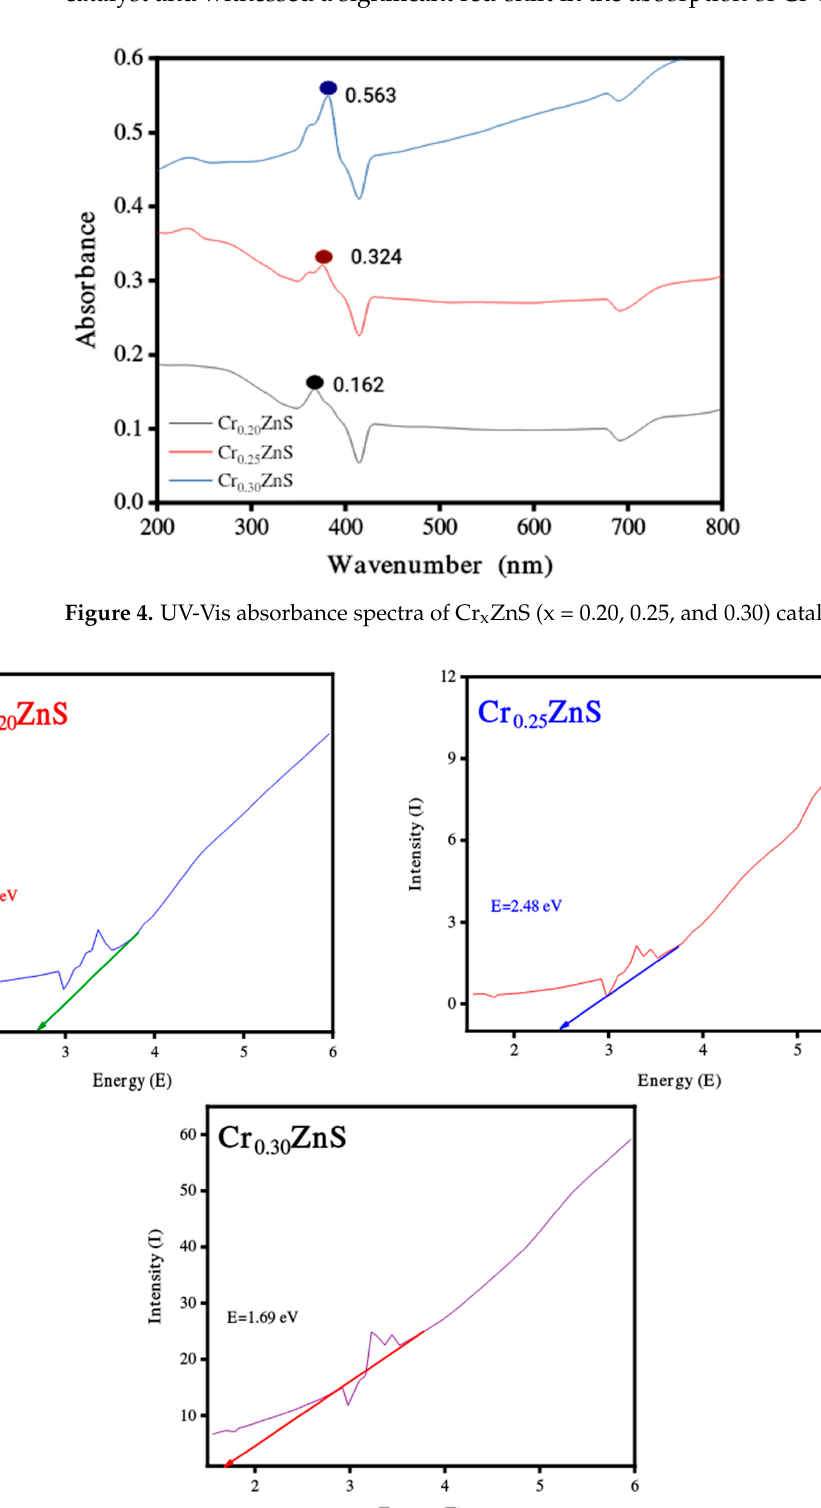
Figure 5. Band gap estimation of Cr 0.20 ZnS, Cr 0.25 ZnS, and Cr 0.30 ZnS catalyst samples.